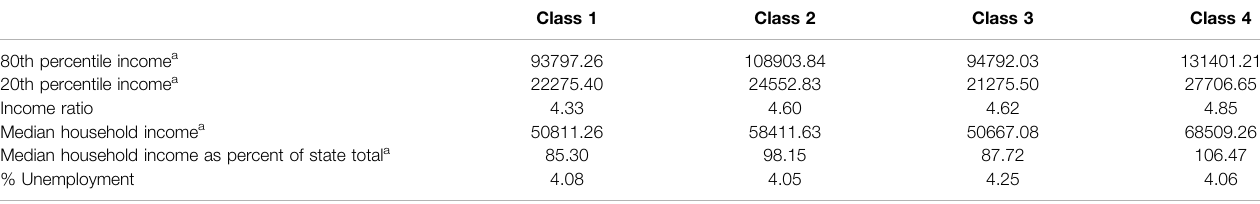
TABLE 9 | Means for income/employment variables by latent class.